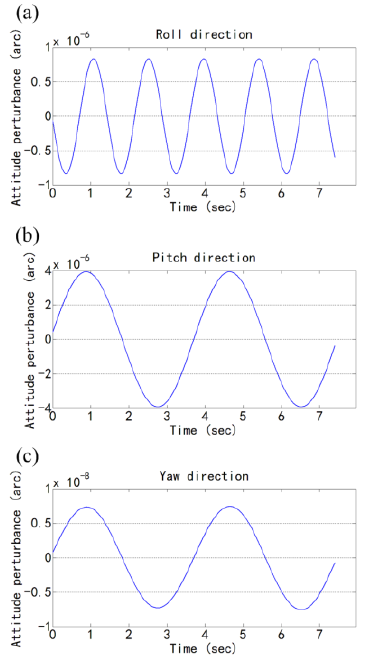
Figure 8. An instance of the scene Orbit 5619-7-130 showing the estimated attitude perturbance